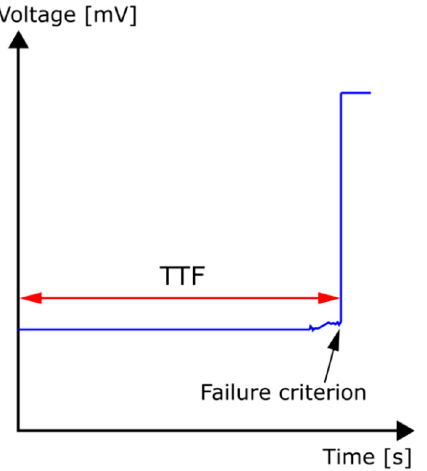
Figure 1. Schematic of the measuring platform for ECM WD tests.